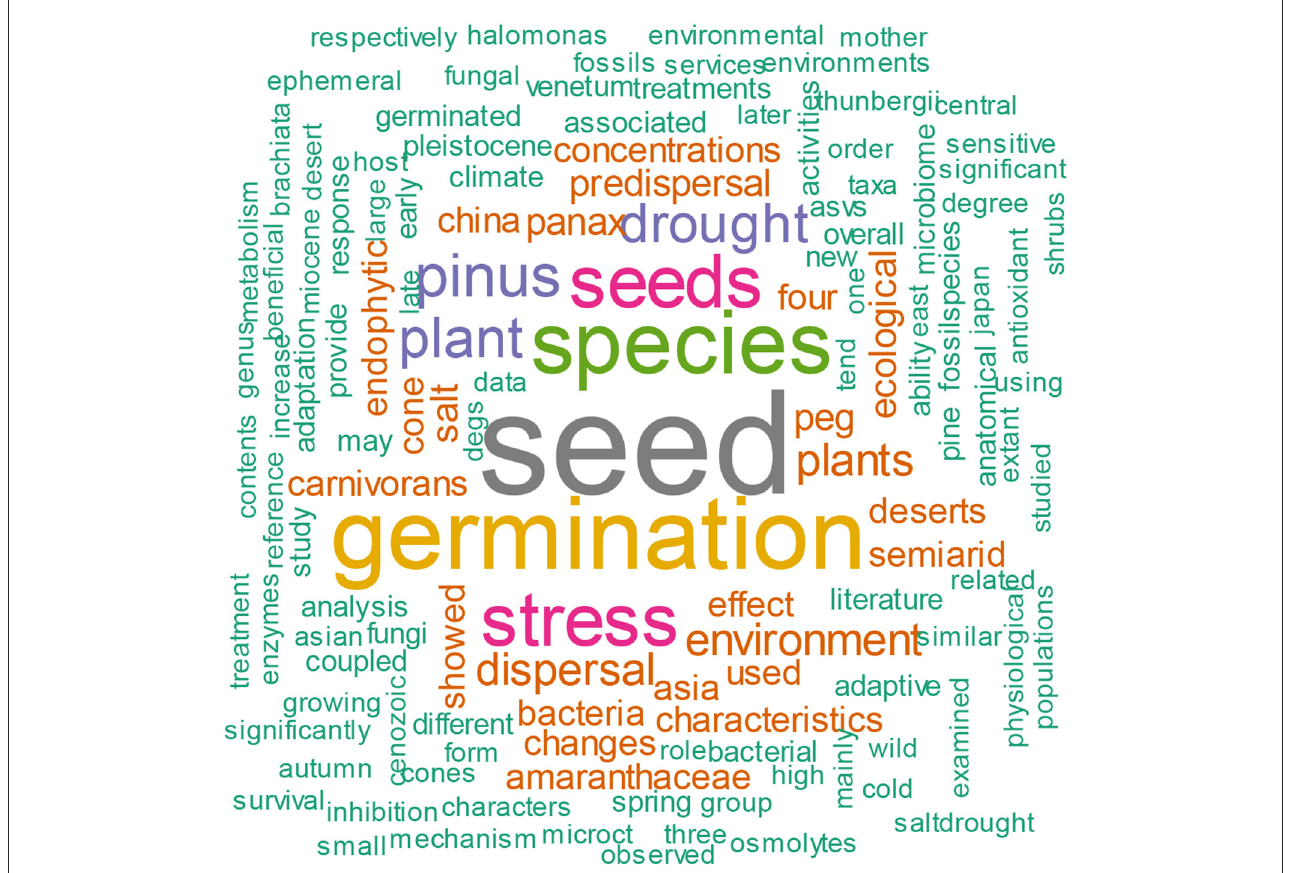
FIGURE1 Word cloud of the abstracts of the six articles within the Research Topic. Seed, germination, stress, drought, and dispersal are among the most frequent